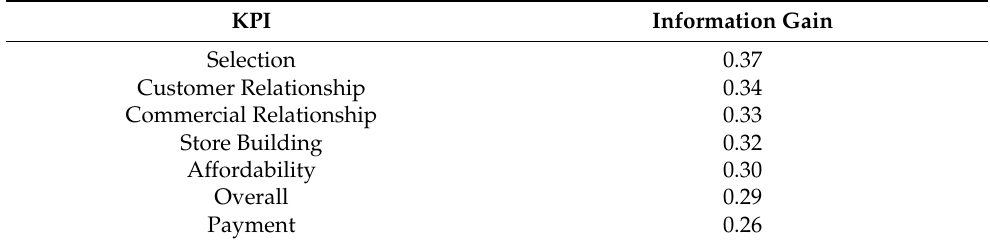
Table 3. Information Gain of the seven